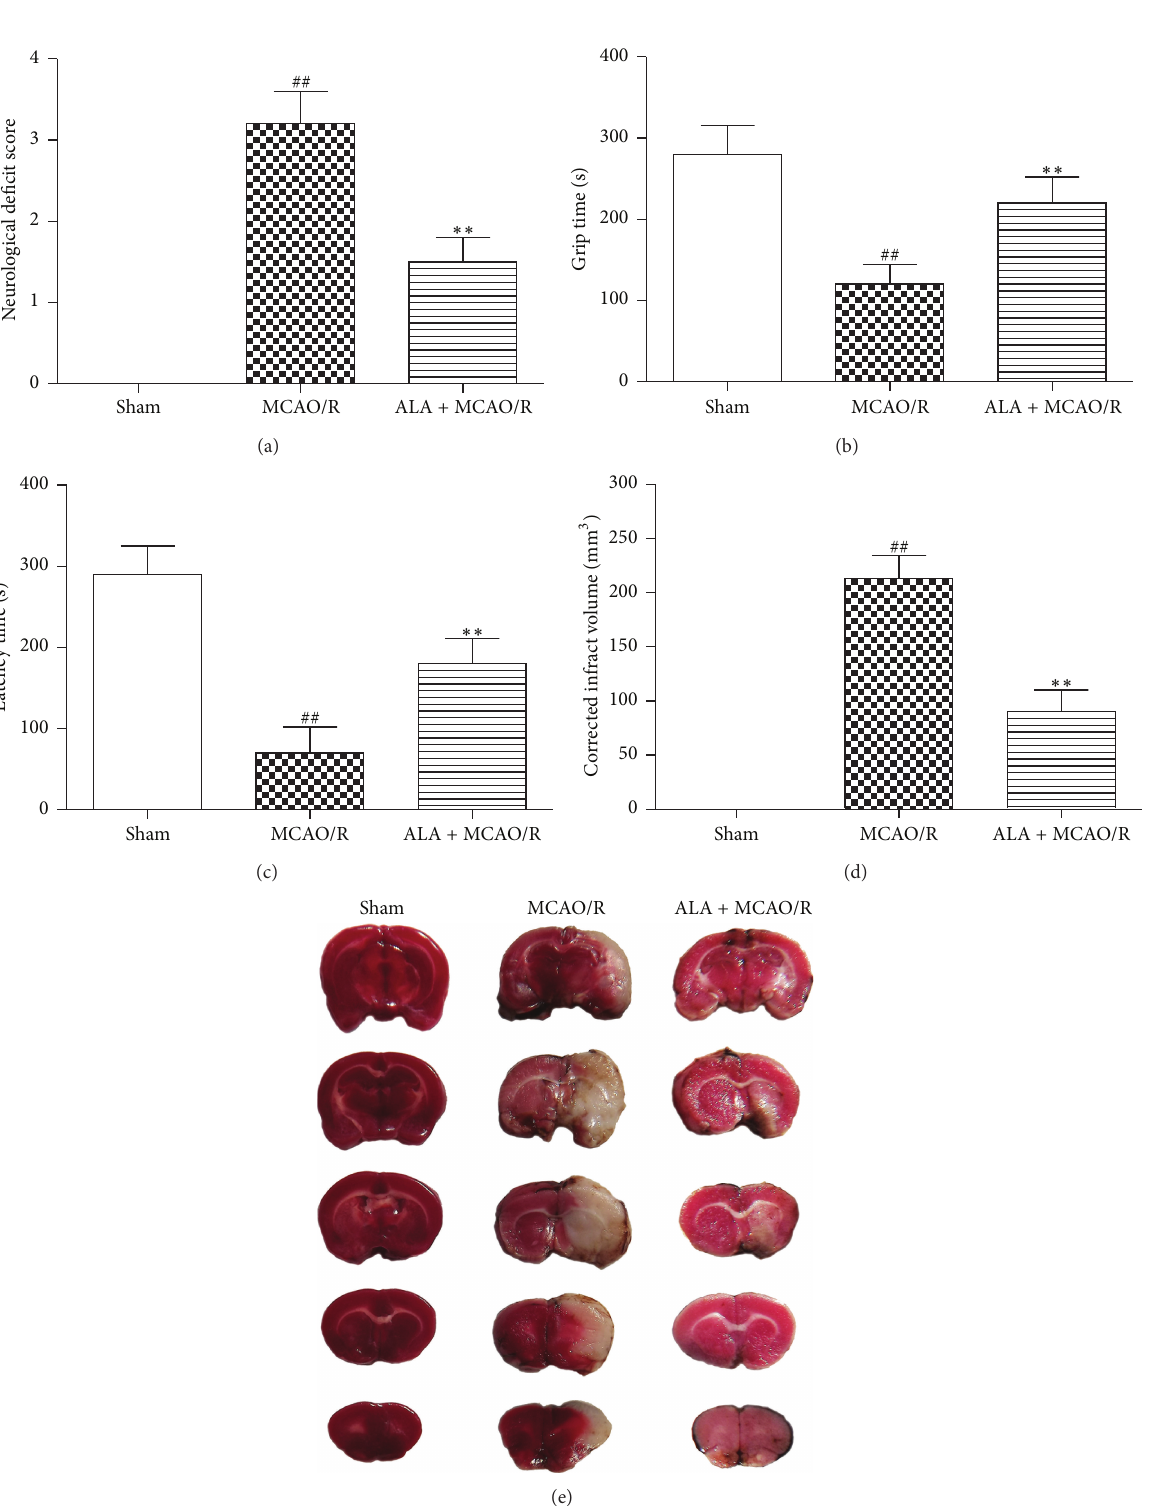
Figure 1: ALA improved neurological functions and attenuated MCAO/R-induced infarct volume. (a) ALA attenuated MCAO/R-induced neurologicaldeficit.(b)ALAamelioratedMCAO/R-inducedreductionofgriptime.(c)ALAattenuatedMCAO/R-induceddecreaseinlatency time in Morris water maze. (d) Quantitative analysis of cerebral infarct volume. (e) ALA inhibited MCAO/R-induced cerebral infarct. For the ALA + MCAO/R group, ALA (40 mg/kg, i.p.) was daily administered to rats for 3 days. For the sham and MCAO/R groups, the rats were given the same amount of ethanol. Data were expressed as means ± SEM. ## 𝑃 < 0.01 compared with the sham group. ∗∗ 𝑃 < 0.01 compared with the MCAO/R